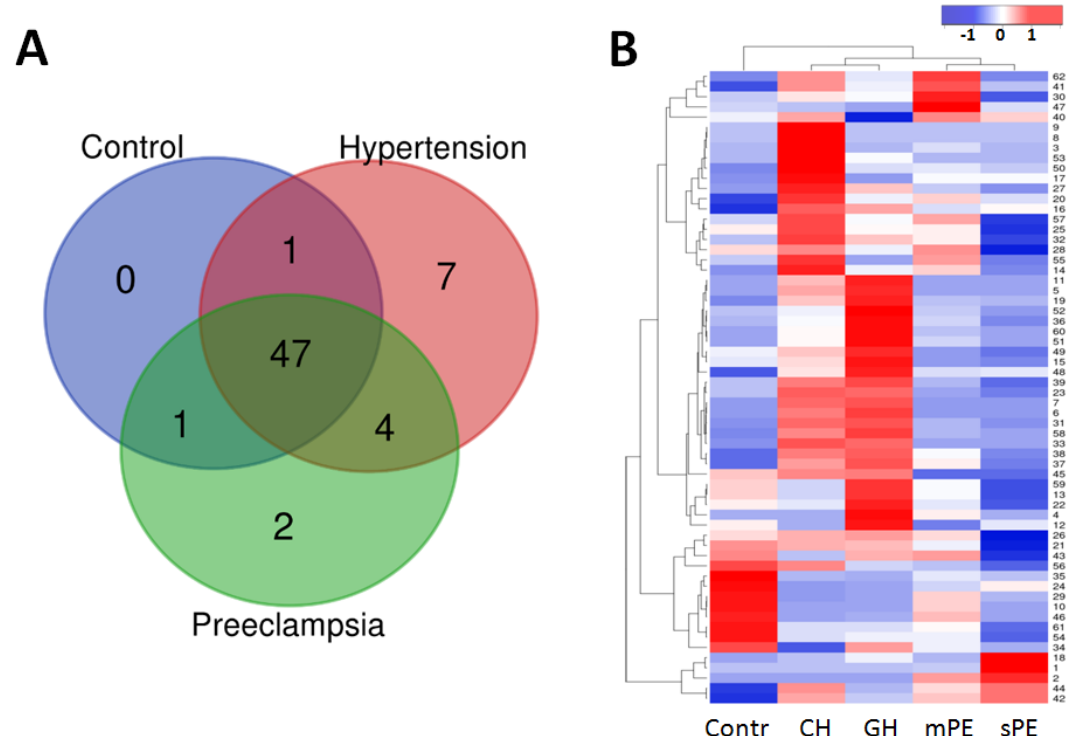
Figure 1. The distribution of 62 substantially represented peptide loci in control, hypertension (CH and GH), and preeclampsia (mPE and sPE) patient groups. ( A ) Venn diagram demonstrating peptide group intersections. ( B ) Hierarchical clustering of the peptide loci’s median intensity values and pregnancy associated hypertensive disorders groups. The Kendal’s Tau distance measurement method and average linkage clustering were used. The higher values are shown in red, the lower—in blue. Table 3. Protein affiliation of the 62 substantial peptide groups in urine of pregnant women.